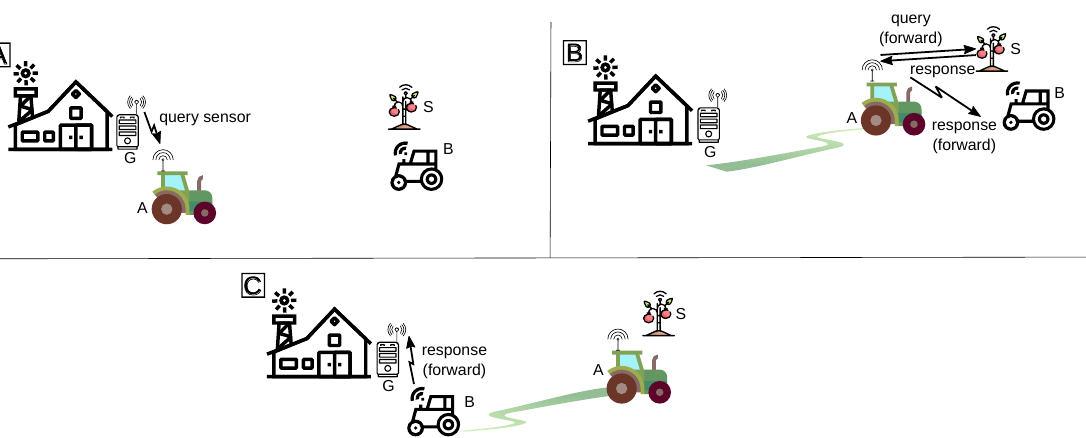
Figure 2. Opportunistic Sensing in a crop monitoring scenario. ( A ) A sensor query is emitted by gateway G. ( B ) Tractor A carries the query to sensor S. ( C ) Another tractor B forwards sensor data back to